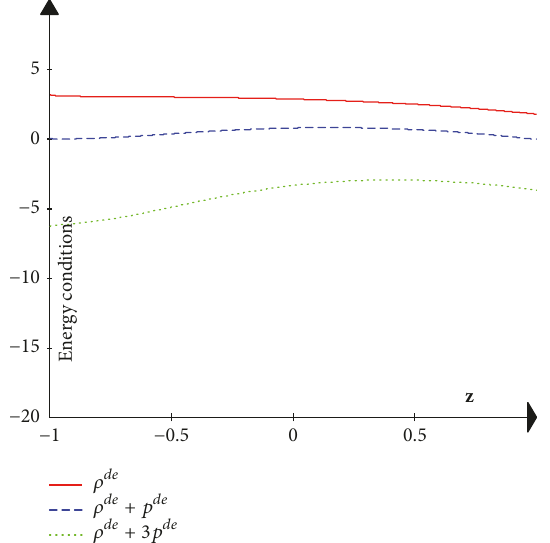
Figure 8: The plot of the weak 𝜌 𝑑𝑒 ≥ 0 , dominant 𝜌 𝑑𝑒 + 𝑝 𝑑𝑒 ≥ 0 , and strong 𝜌 𝑑𝑒 + 3𝑝 𝑑𝑒 ≥ 0 energy conditions versus redshift 𝑧 for interacting scenario.